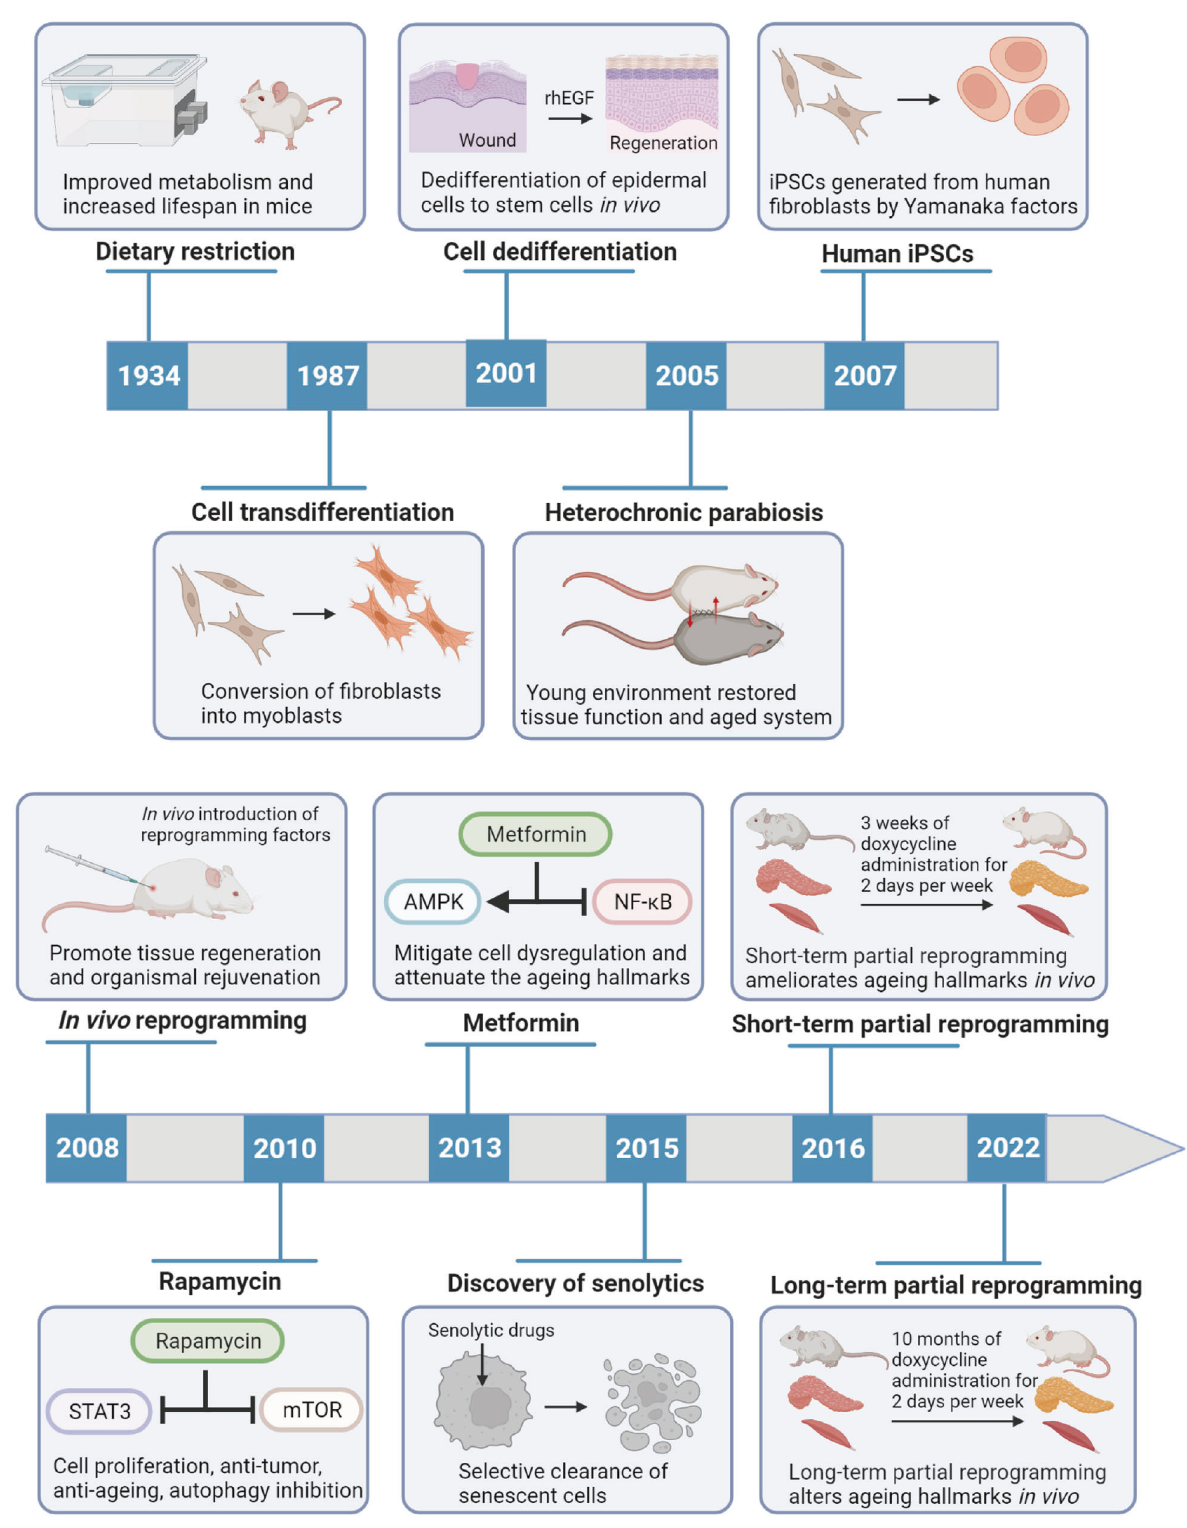
Fig. 1 The milestone events for cellular rejuvenation research advances. Starting with the 1934 discovery of the in fl uence of dietary restriction on lifespan extension, important fi ndings on the subject of cellular rejuvenation are emphasized. More recently, the senolytics development and reprogramming technology have been widely applied for cellular rejuvenation. rhEGF recombinant human epidermal growth factor, iPSCs induced pluripotent stem cells, AMPK 5 ’ -AMP-activated protein kinase, NF- κ B nuclear factor- κ B, STAT3 signal transducer and activator of transcription 3, mTOR mammalian target of rapamycin. Created with BioRender.com